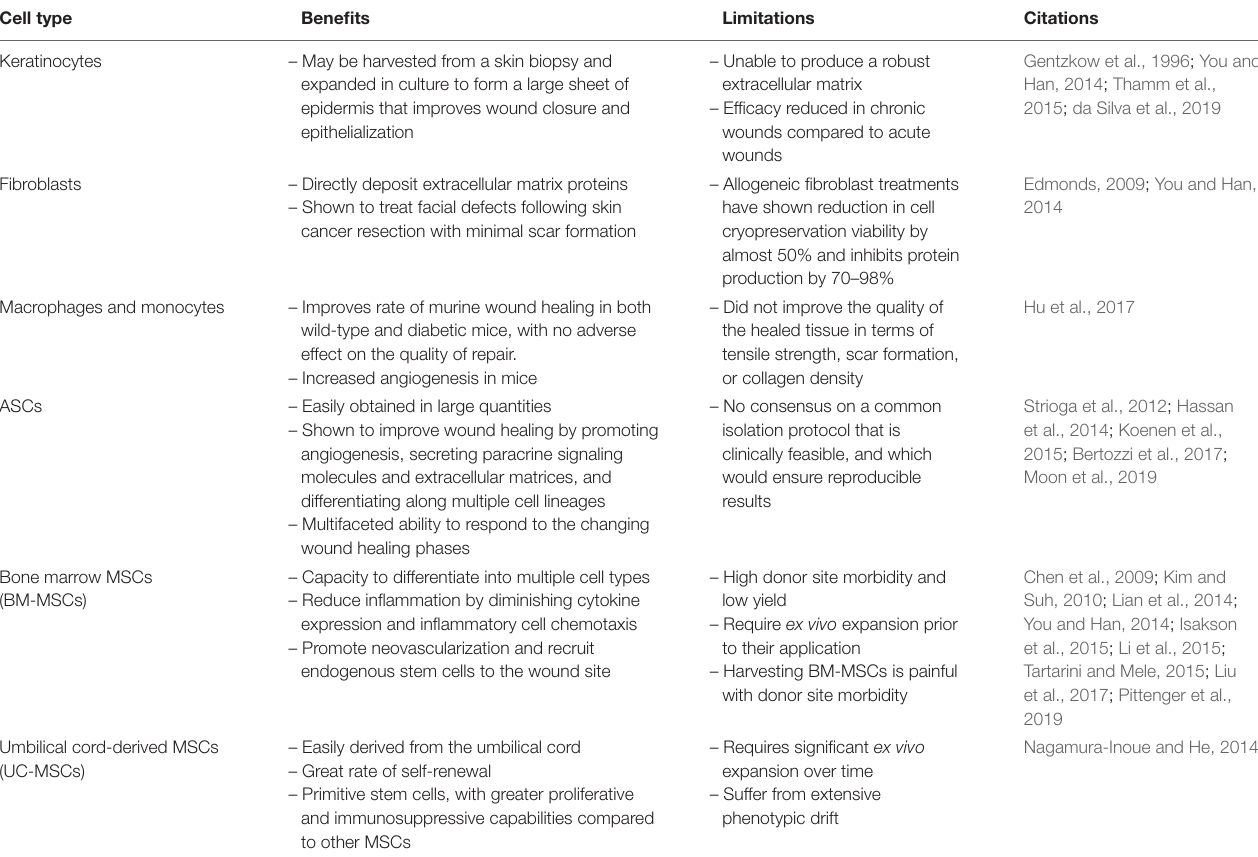
TABLE 1 | Cell therapies tested for wound